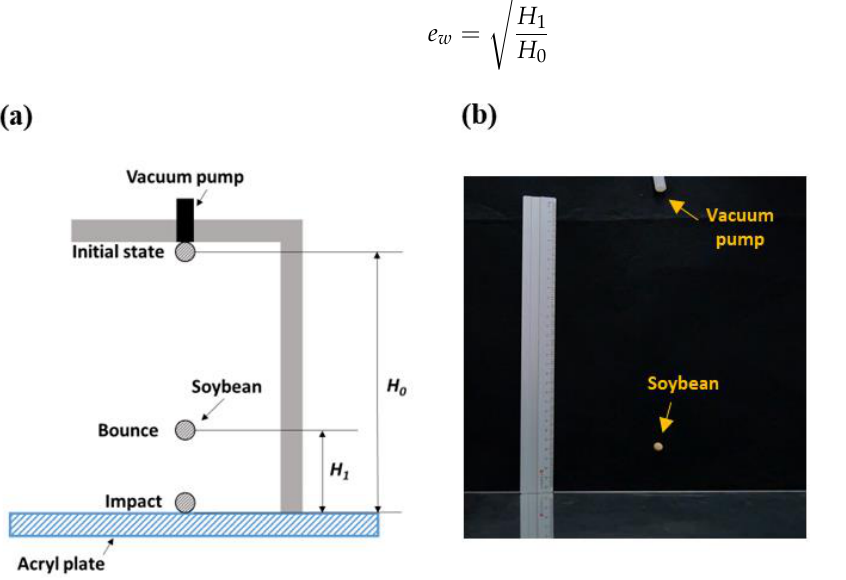
Figure 3. Schematic apparatus and method to determine the particle–wall coefficient of restitution ( a ) and the image taken during the experiment ( b ).